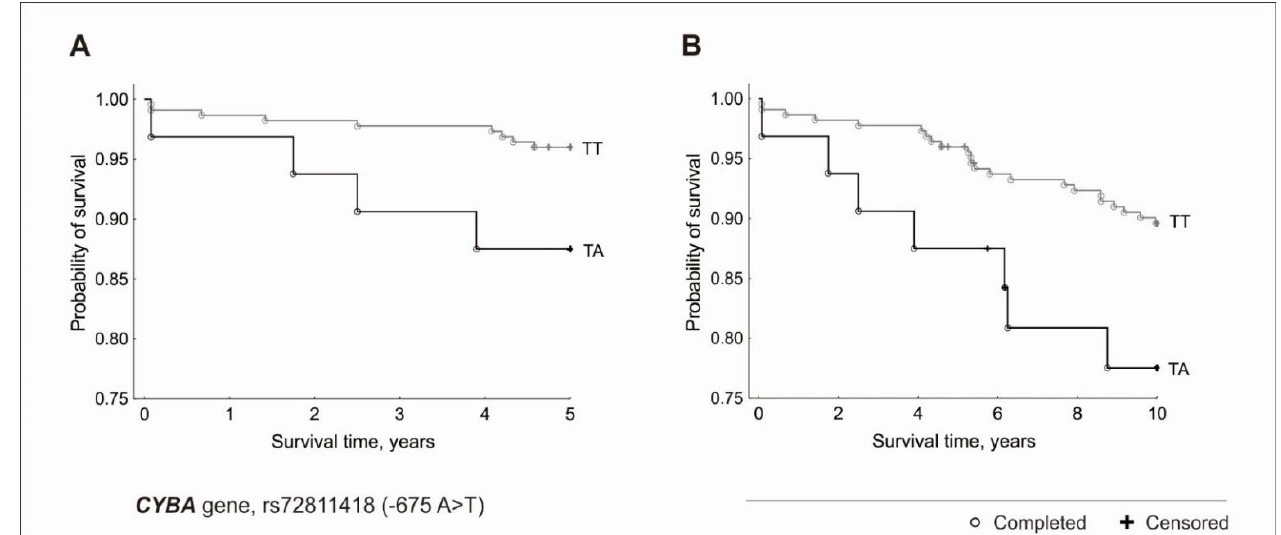
Figure 3. Kaplan-Meier survival curves for CAD patients by CYBA gene, rs72811418 ( − 675 A > T): ( A ) 5-year survival in additive model ( p = 0.048 in the Cox proportional hazard model, p = 0.04 in the χ2 test). ( B ) 10-year survival in additive model ( p = 0.04 in the Cox proportional hazard model, p = 0 .04 in the χ2 test).